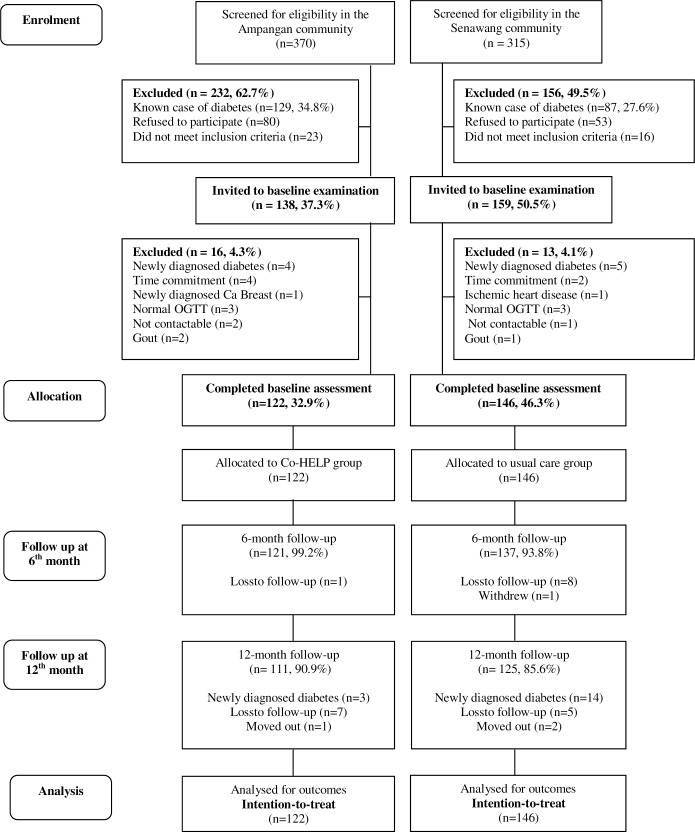
Study flow of participants.